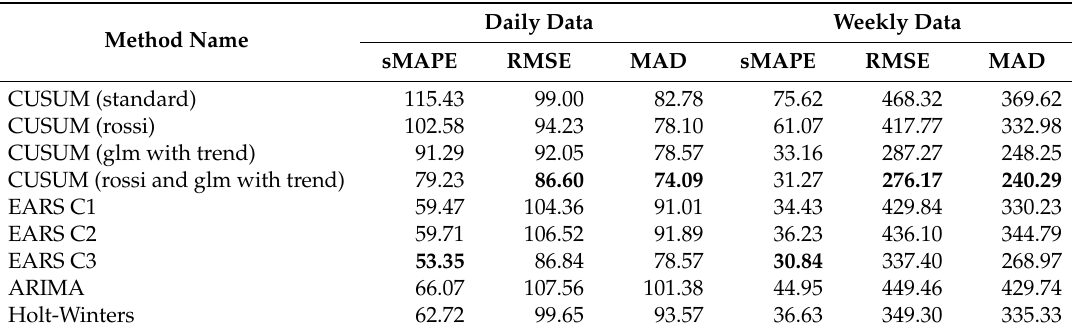
Table 3. The results of syndromic diarrhea surveillance data for each